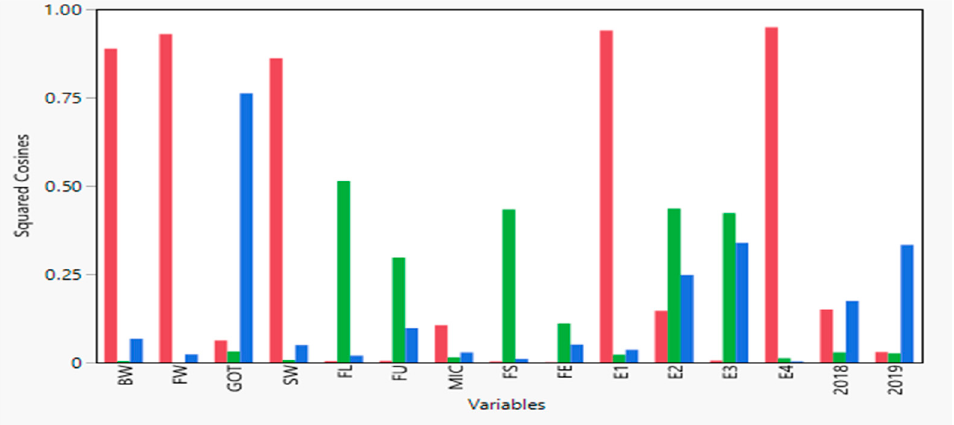
Figure 3. Squared cosines associated with the principal components for the studied traits, treatment effects (E1–E4), and years 2018 and 2019.